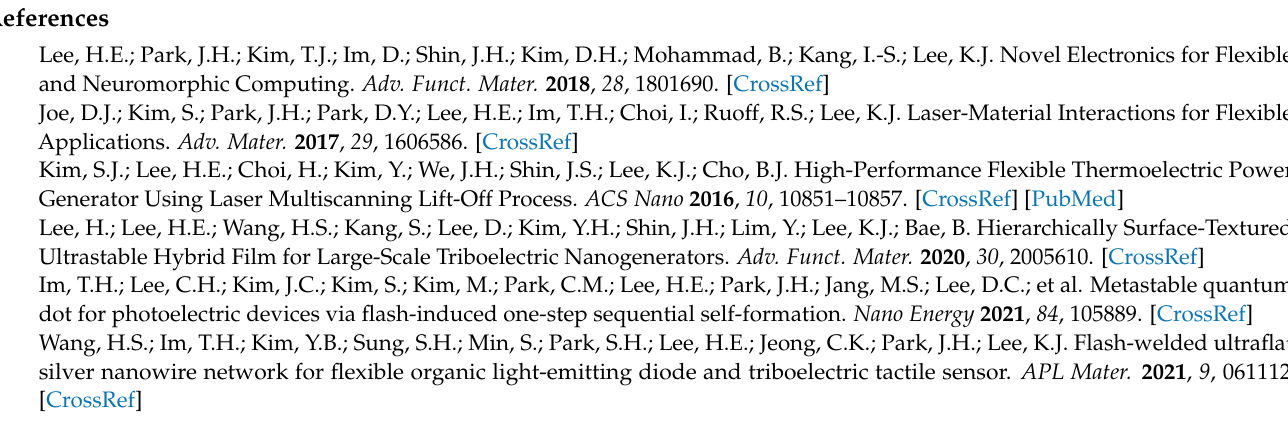
Figure 10. Development roadmap of μ LEDs for display and biomedical applications.